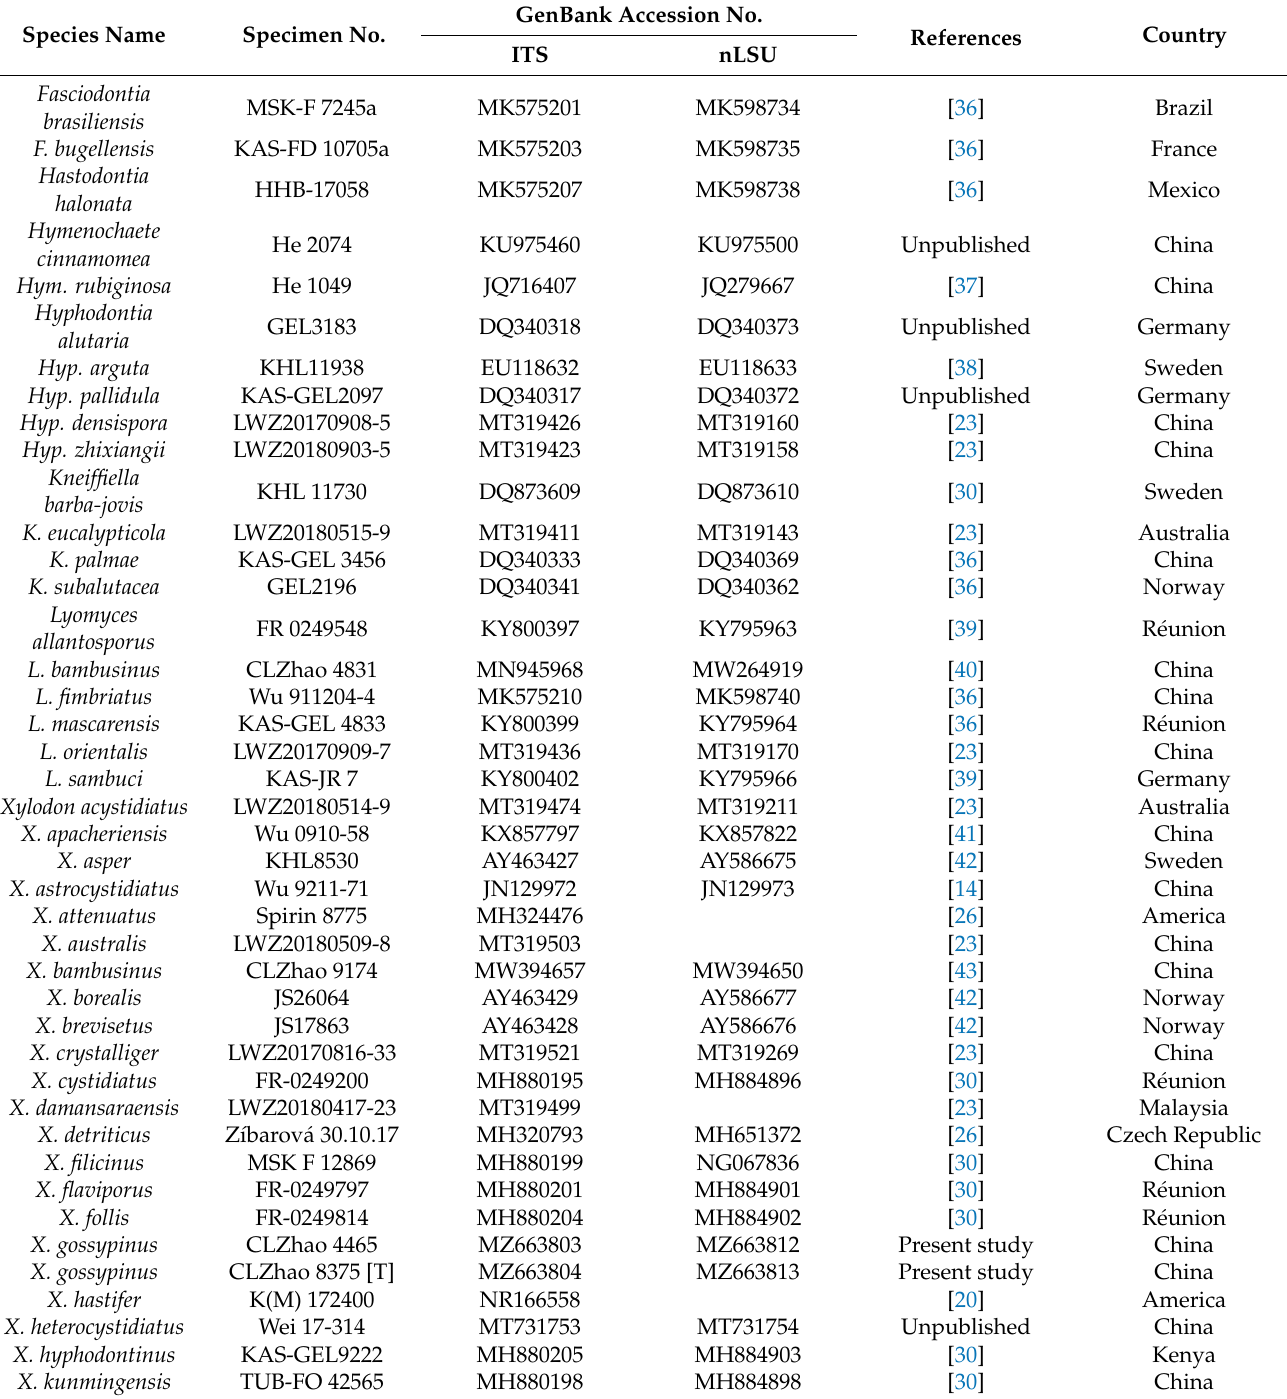
Table 1. List of species, specimens, and GenBank accession numbers of sequences used in this